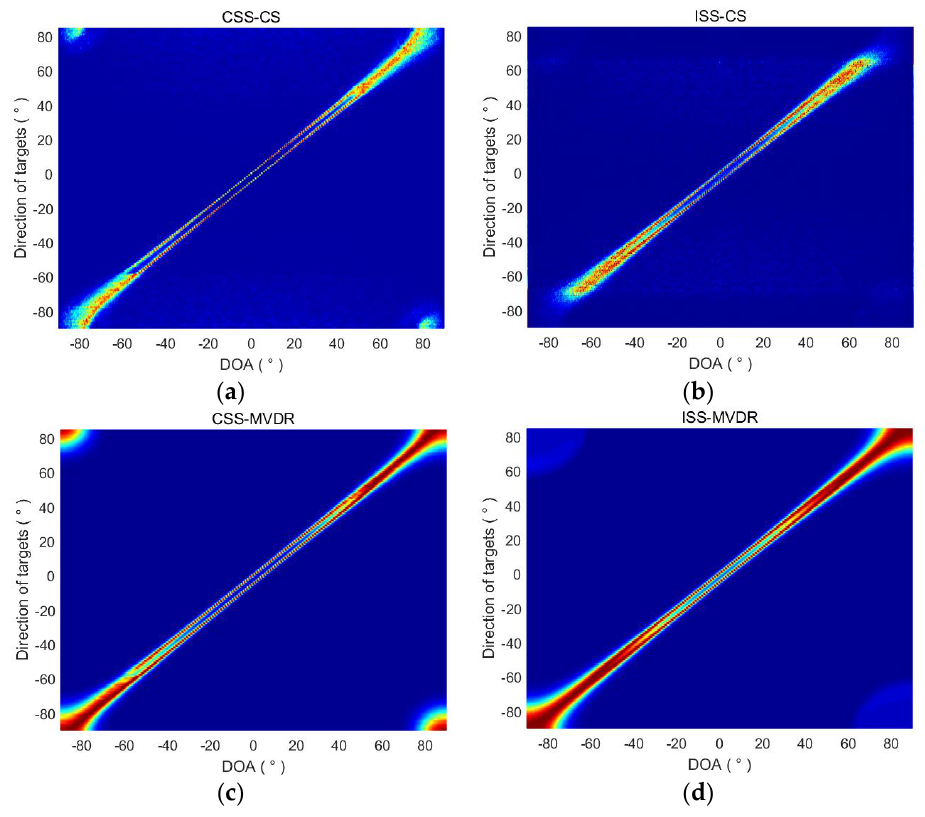
Figure 4. DOA estimation results of CSS-CS, ISS-CS, CSS-MVDR and ISS-MVDR in terms of target directions. ( a ) DOA estimation results of CSS-CS; ( b ) DOA estimation results of ISS-CS; ( c ) DOA estimation results of CSS-MVDR; ( d ) DOA estimation results of ISS-MVDR